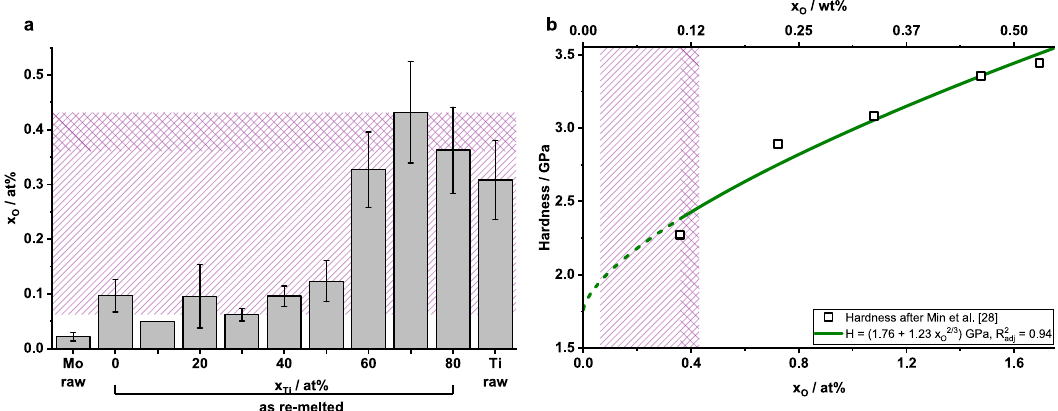
Fig. 4 Interstitial O and its correction. a The O contents of the alloys determined by HCGE in at%. N contents were below 200 at-ppm for all alloys. b Vickers hardness H of quenched Ti-9Mo solid solutions as a function of O content x O , taken from ref. 28 . The green line shows a Labusch-like fi t to the data. The dashed part indicates the extrapolation to zero O. As reference, the top axis shows the O content w O in wt%. The range of O correction by extrapolation is shown as single-hatched area in both images. The double-hatched area indicates the range of O correction by interpolation.